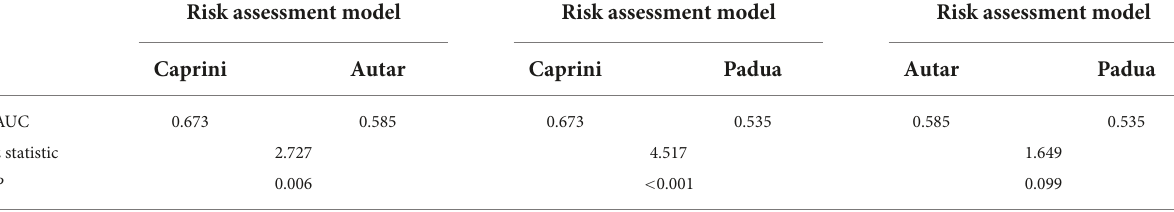
TABLE 4 Comparison of AUCs for the three thrombosis risk assessment